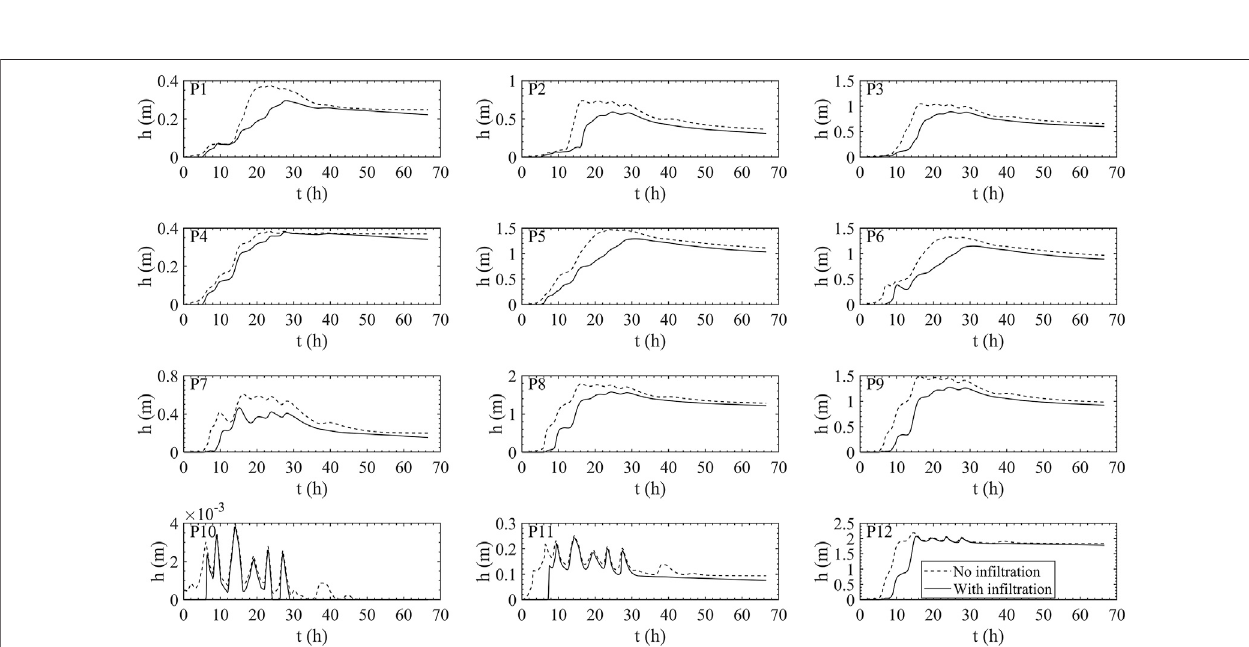
FIGURE 14 | Temporal evolution of water depth at 12 selected points for PSWM with and without in fi ltration.